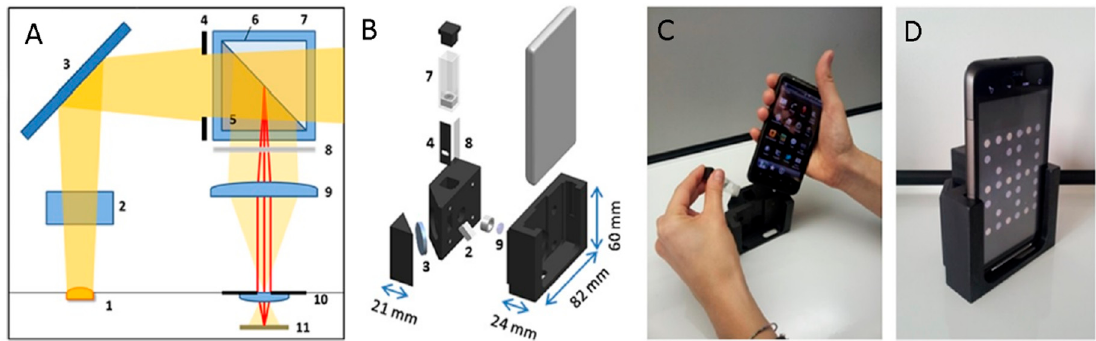
Figure 13 . Optical ( A , B ) mechanical schemes of the Giavazzi et al. smartphone-based biosensing device. ( C ) Image of the assembled cradle during the insertion of the smartphone and the cartridge and the results of the analysis displayed on the screen of the smart phone ( D ). Adapted with permission from [132].